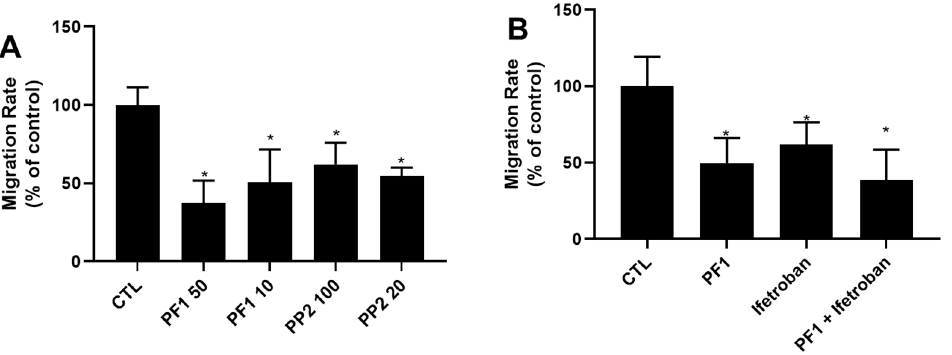
Figure 7. Effect of phytoprostanes on Transwell migration of MDA-MB-231 Cells. ( A ) PF1 and PP2 can inhibit cellular migration of MDA-MB-231 cells. ( B ) Ifetroban does not modulate PF1-mediated inhibition of cellular migration in a Transwell assay. Experiments were performed using Transwells. Briefly, media in the bottom well contained DMEM 5%FBS with or without PF1 (500 µM) or ifetroban (2 µM). Cells (in media with 0.5%FBS) were added to the top well at 10,000 cells/well. Twelve hours after, cells were stained with crystal violet. Results are presented as the percent of control (no treatment). * denotes a statistical significance when compared to the control group ( p < 0.05).3.6. PF1 promotes the adhesion of MDA-MB-231 cells.